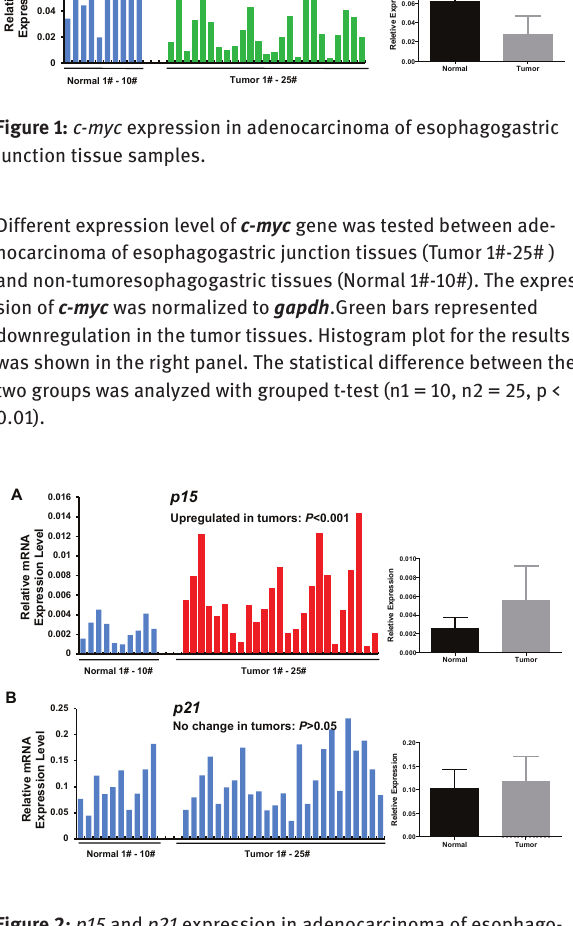
qRT-PCR. The expression of p15 and p21 was normalized to gapdh. Red bars represented upregulation in the tumor tissues. Histogram plot for the results in the right panels. The statistical differences between samples were analyzed with grouped t-test (n1 = 10, n2 = 25).